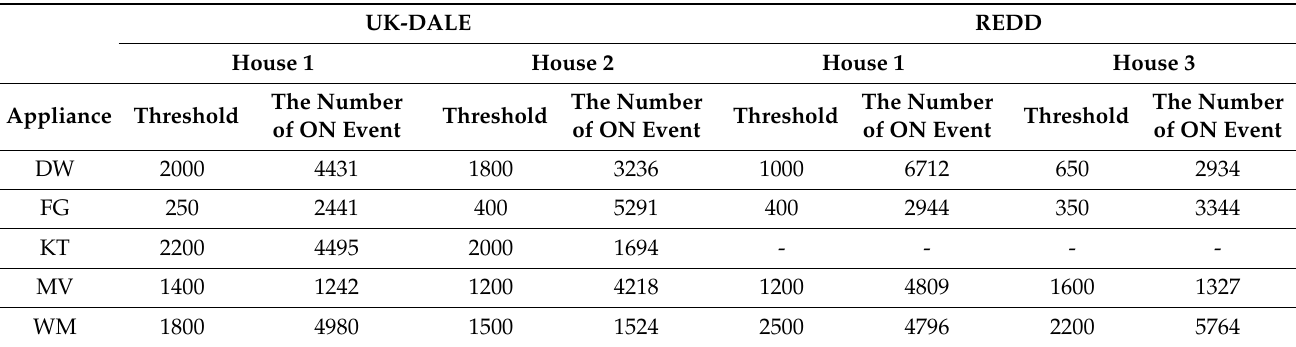
Figure 4. Power usage and ON thresholds for House 1 and House 3 in the REDD dataset. Table 1. ON threshold and the number of ON events in UK-DALE and REDD